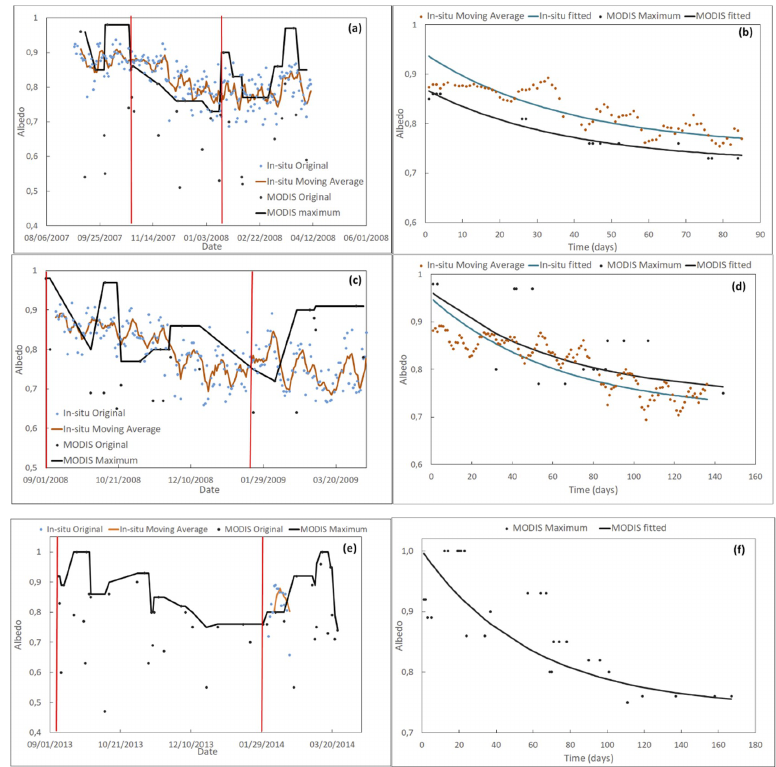
Figure 9. Left column: original in-situ albedo (blue dots), original MOD10A1 albedo (black dots), in-situ albedo moving average (brown solid line) and filtered MOD10A1 albedo (black solid line) from September 1 to April 10. Right column: in-situ albedo moving average (brown dots) and filtered MOD10A1 albedo and the corresponding fit to the exponential decay. Season 2007 – 2008 (( a ) and ( b )), season 2008 – 2009 (( c ) and ( d )), season 2013 – 2014 (( e ) and ( f )). The vertical red lines in ( a ), ( c ) and ( e ) indicate the start and end dates of the snow melting.